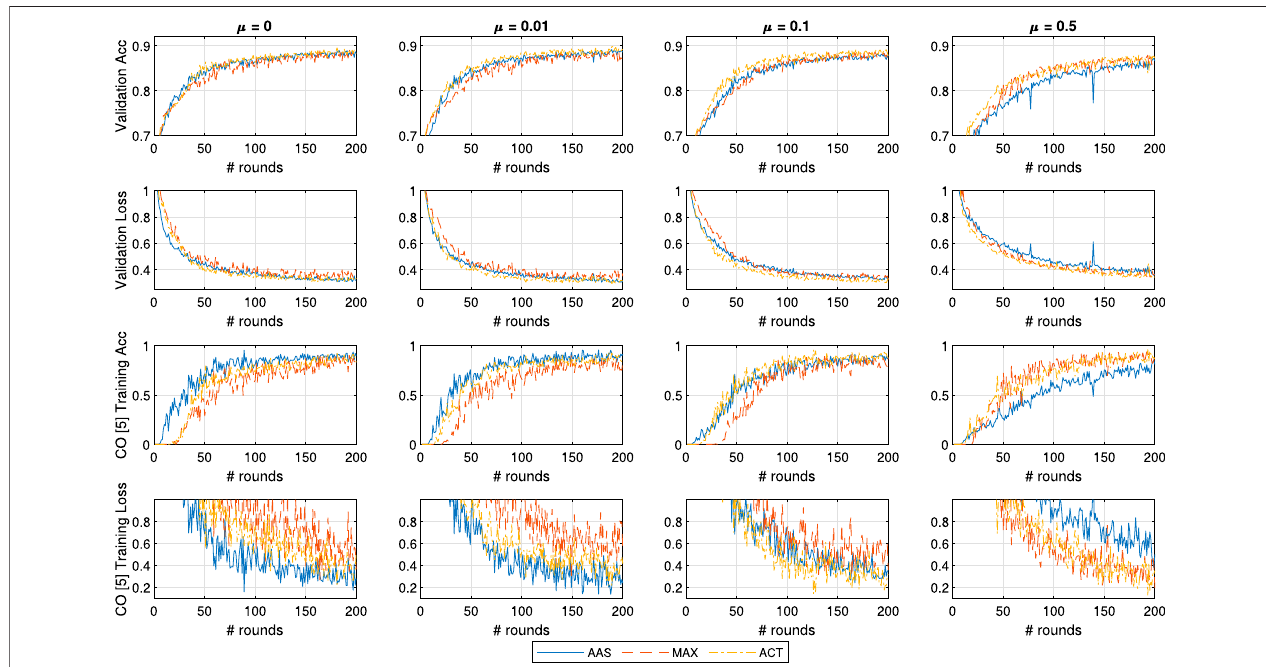
FIGURE 6 | General and CO-speci fi c accuracy and loss results obtained when testing all three methods in combination with FedProx using the FMNIST dataset.